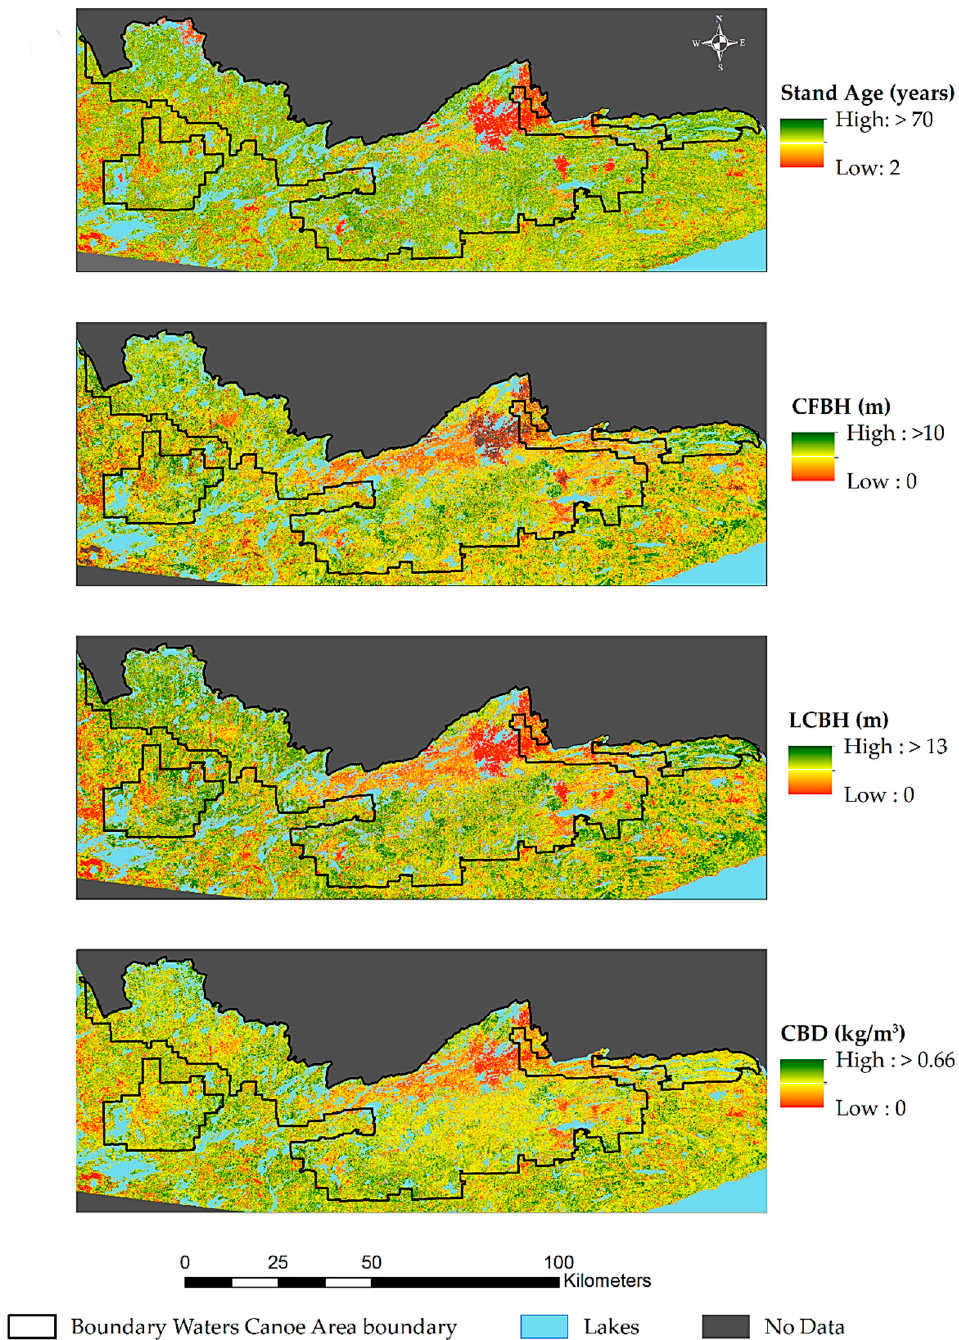
Figure 6. Imputation predictions across the study area for Stand Age, Crown Fuel Base Height (CFBH), Live Crown Base Height (LCBH), and Canopy Bulk Density (CBD).